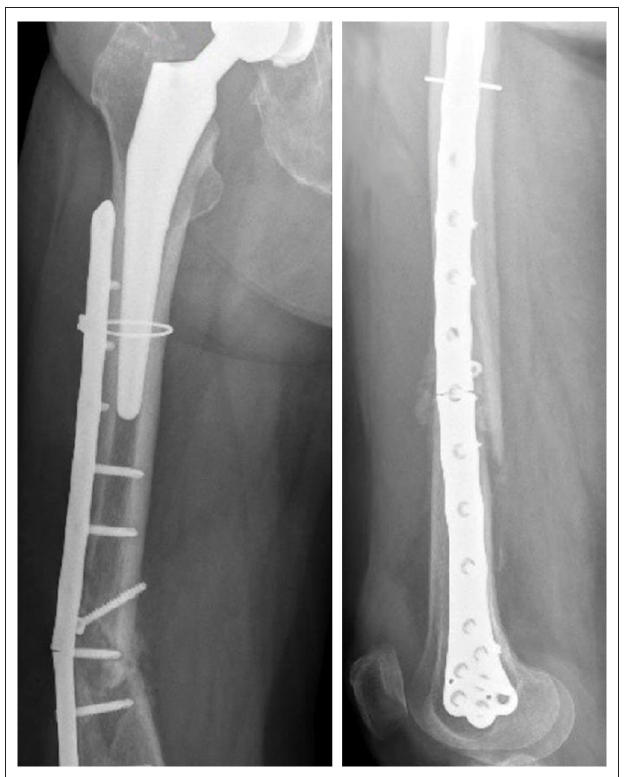
FIGURE 3 | Anteroposterior (Left) and lateral (Right) x-ray images of the plate break.